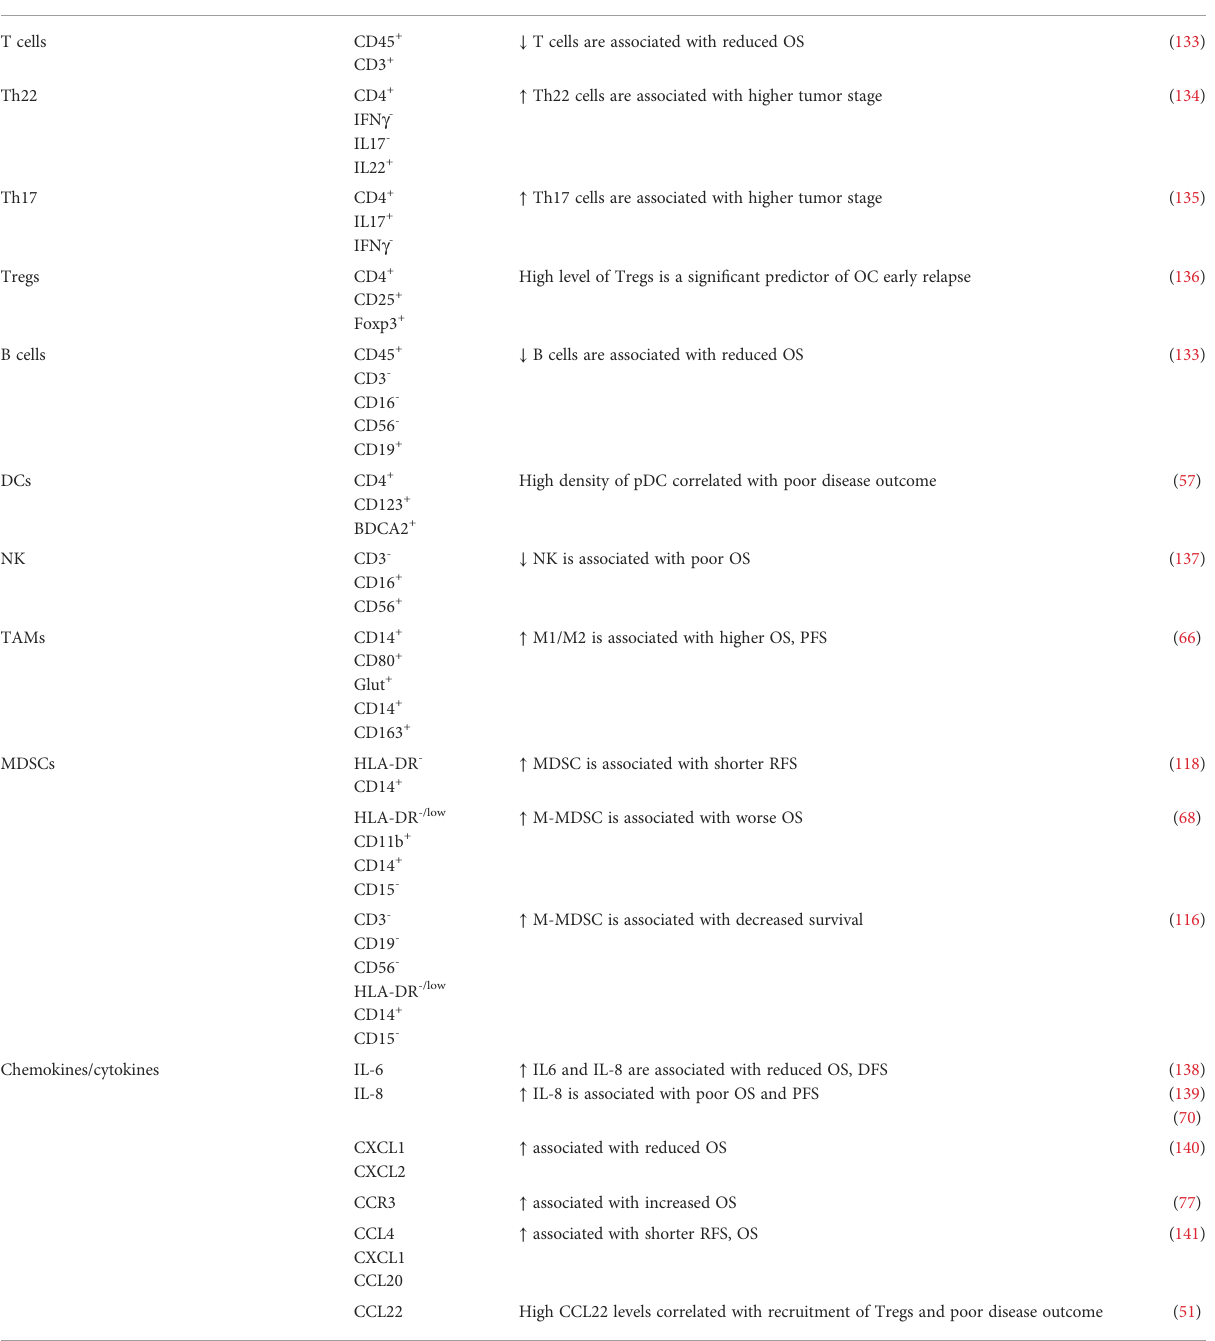
TABLE 2 Circulatory immune pro fi les and their clinical signi fi cance in ovarian